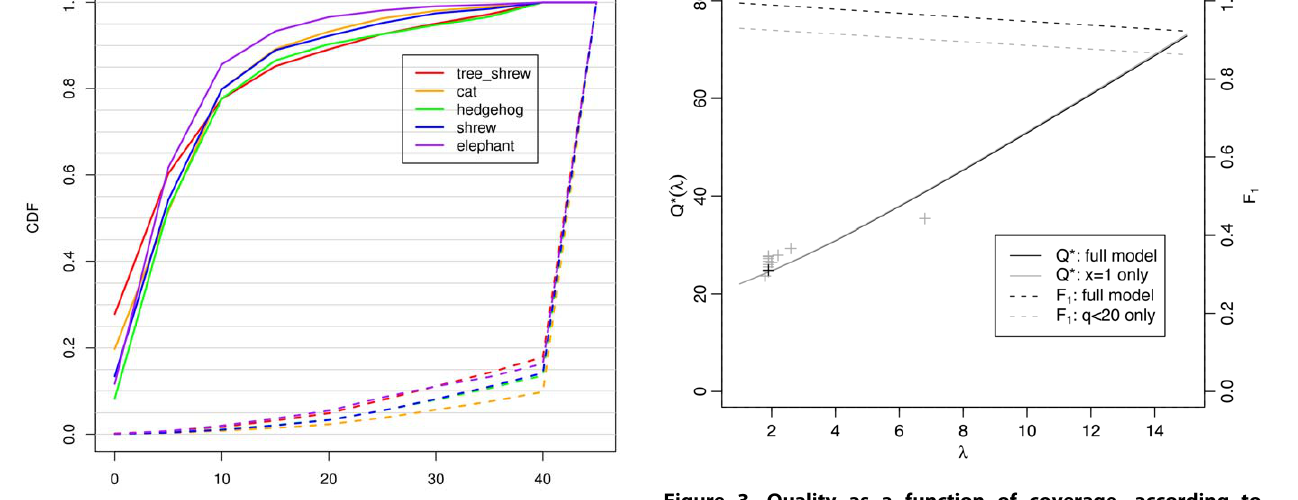
Figure 3. Quality as a function of coverage, according to theoretical model. Shown are expected coverage ( l ) versus expected sequence quality ( Q * ( l ); solid curves, labels on left) and expected fraction of error contributed by single-coverage regions of an assembly ( F 1 ; dashed curves, labels on right). Sequence quality is expressed in phred units, as Q *( l )=10 log 10 err( l ), where err( l ) is the error probability per base. The solid black curve shows that expected sequence quality increases nearly linearly with expected coverage, at a rate of , 3.62 phred units per additional 1 6 of coverage, corresponding to a 10 2 3.62/lO < 43% decrease in the error rate. The nearly identical solid gray curve considers only errors from single-coverage ( x =1) portions of the assembly, demonstrating that average error rates are almost completely determined by single-coverage regions of the assembly, and increases in quality are almost completely attributable to decreases in single-read coverage. The dashed black curve shows the fraction of all errors that come from single-coverage bases (F 1 ), and the dashed gray curve shows the fraction that come from low quality ( q , 20) single-coverage bases, which occur predominantly at the ends of reads. Notice that, even at quite high levels of average coverage, the vast majority of errors are predicted to come from the ends of reads in single-coverage regions of an assembly. These calculations are based on a distribution of single-read quality scores estimated empirically from the tupBel1 (Northern Tree Shrew) assembly (see Materials and Methods). For comparison, points corresponding to the error rates in Table 2 are shown (plus symbols), with tupBel1 in black. Departures from the theoretical predictions are partially explained by departures from the assumption of Poisson-distributed read depths (Table S4).